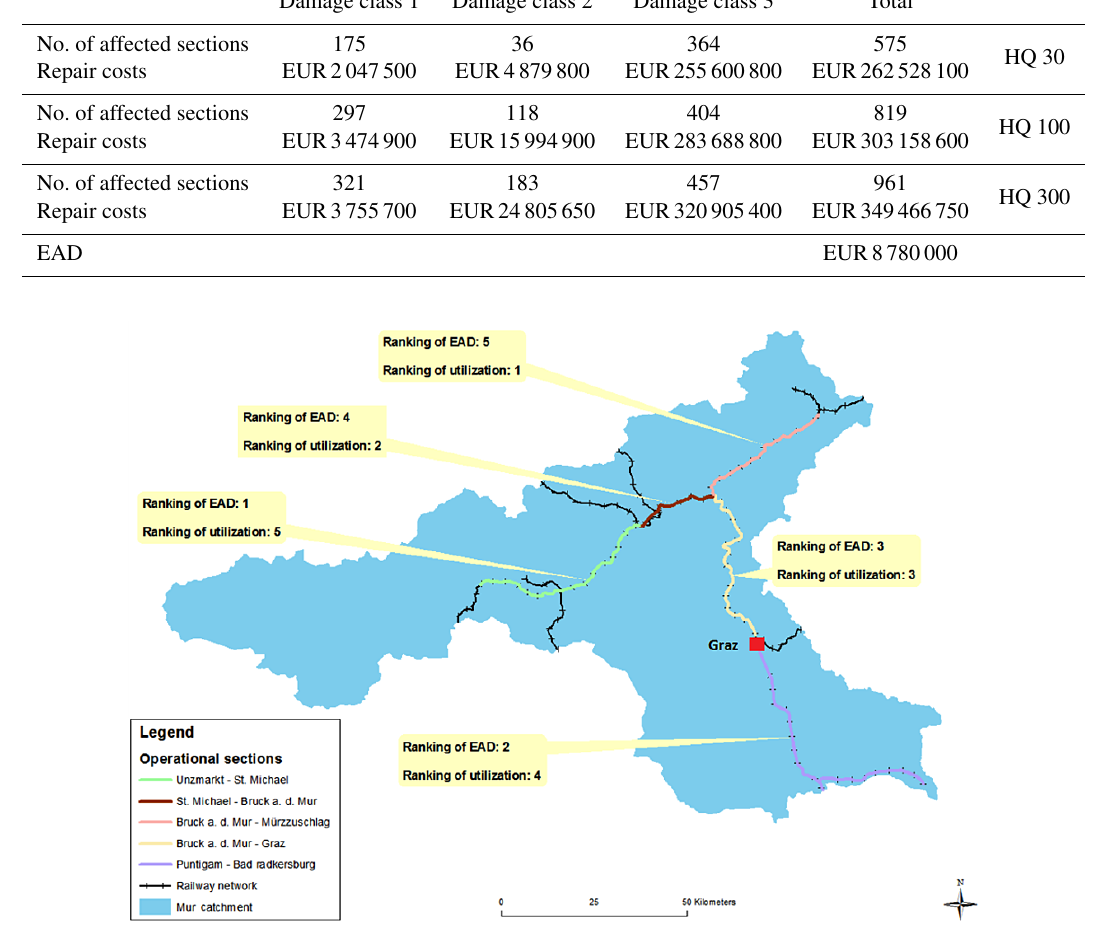
Figure 4. Operational sections of the railway subnetwork. The yellow boxes provide the individual rankings according to the EAD value and the track utilization figure of